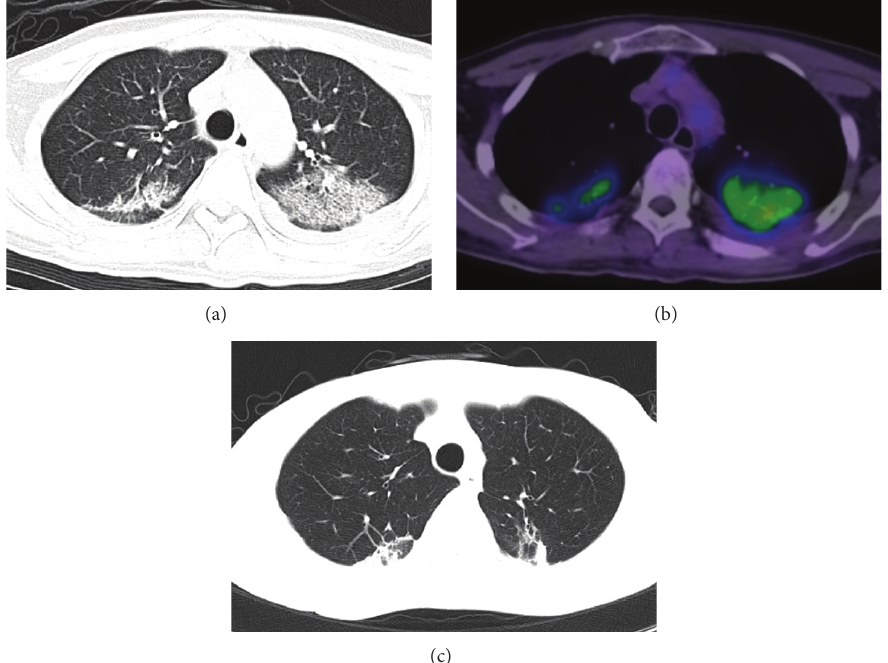
Figure 2: (a) HHV-6 pneumonitis. The data shown here was acquired after CBT. CT scan on day 33 showed reticulation, ground-glass opacity, consolidation, and peripheral lung sparing in bilateral lung fields. (b) FDG-PET scan on day 41 revealed a maximum standard uptake value of 6.0 in bilateral lung fields. (c) HHV-6 pneumonitis was diminished after foscarnet therapy as assessed by CT scan on day 82.